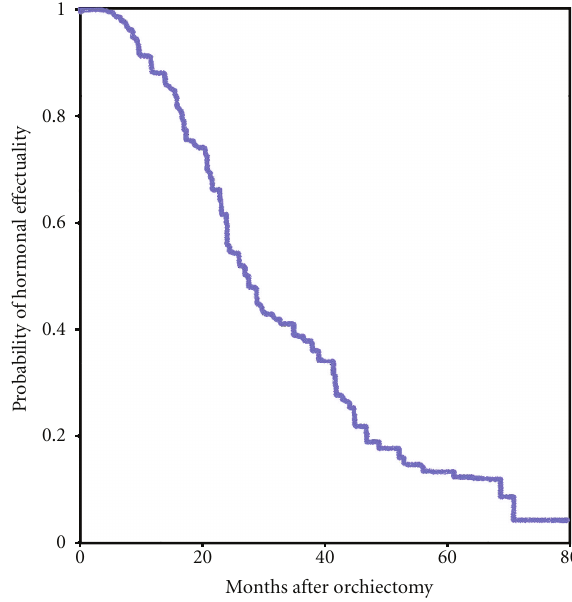
Figure 1: Time of tumor remission in 83 patients with osseous metastasized prostate cancer after subcapsular orchiectomy (Kaplan-Meier